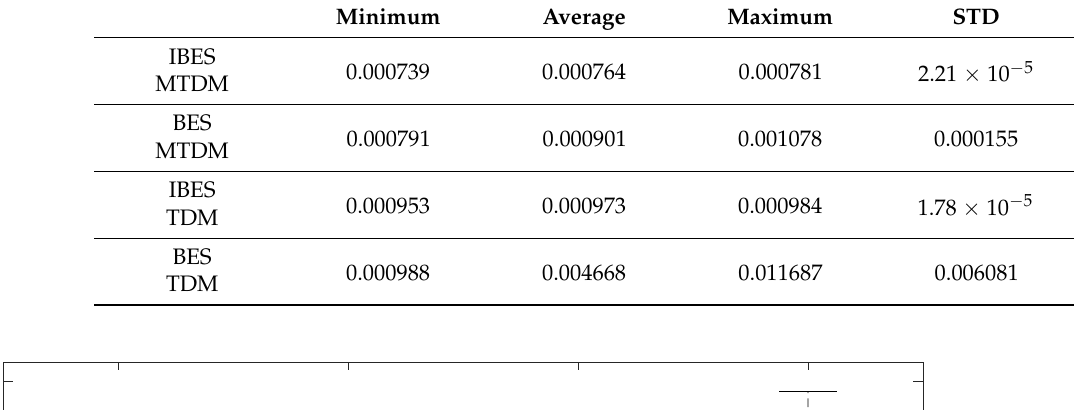
Table 7. Statistical results for the IBES applied to the MTDM and TDM and for the BES applied to the MTDM and TDM.